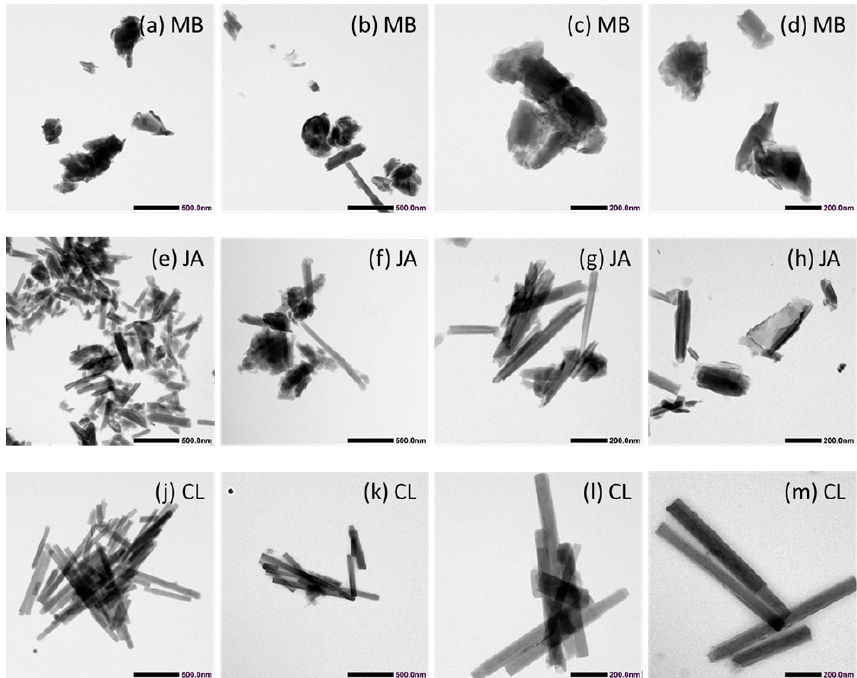
Figure 10. TEM micrographs of milled samples at two different magnifications (see length bars within the images). Dust sample codes are identical to those in Fig.